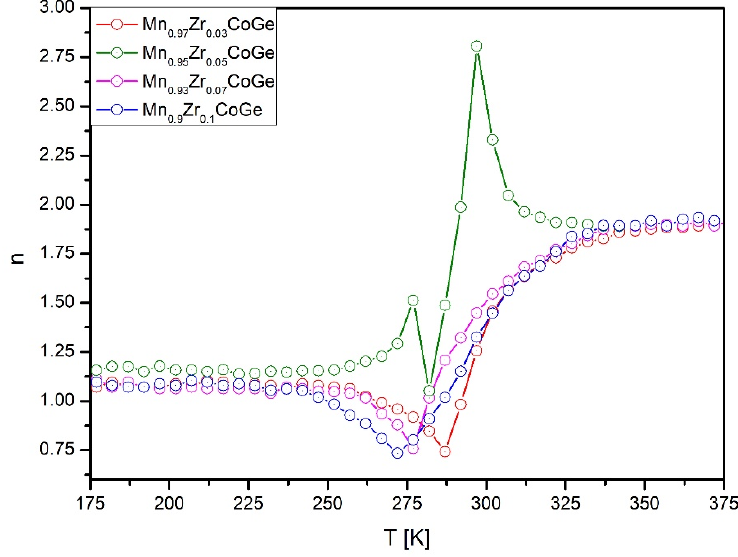
Figure 8. The temperature dependences of the exponent n calculated for all investigated samples.